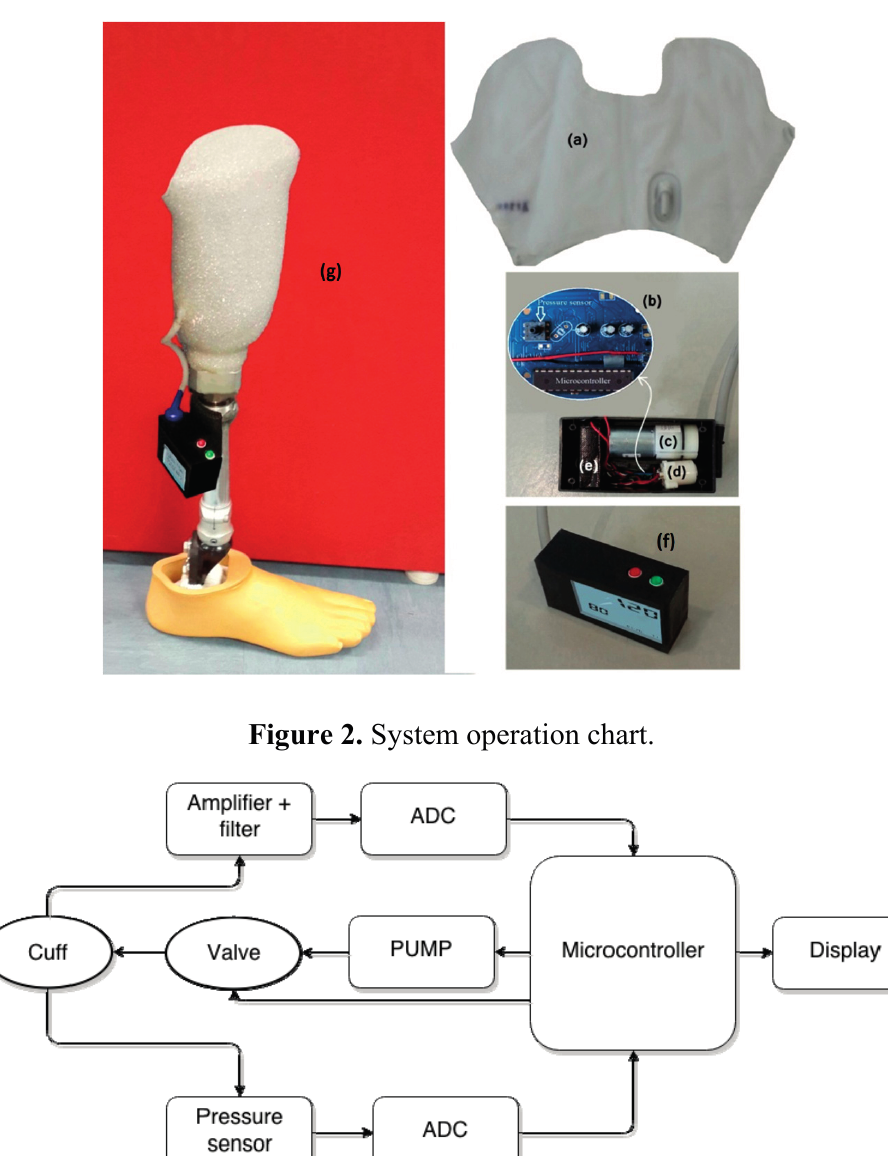
Figure 1. Feature and components of the APSS: Bladder ( a ); Control circuit board (including a pressure sensor and microcontroller) ( b ); Pump ( c ); Valve ( d ); Battery ( e ); Operation system ( f ); Assembled transtibial prostheses ( g ).